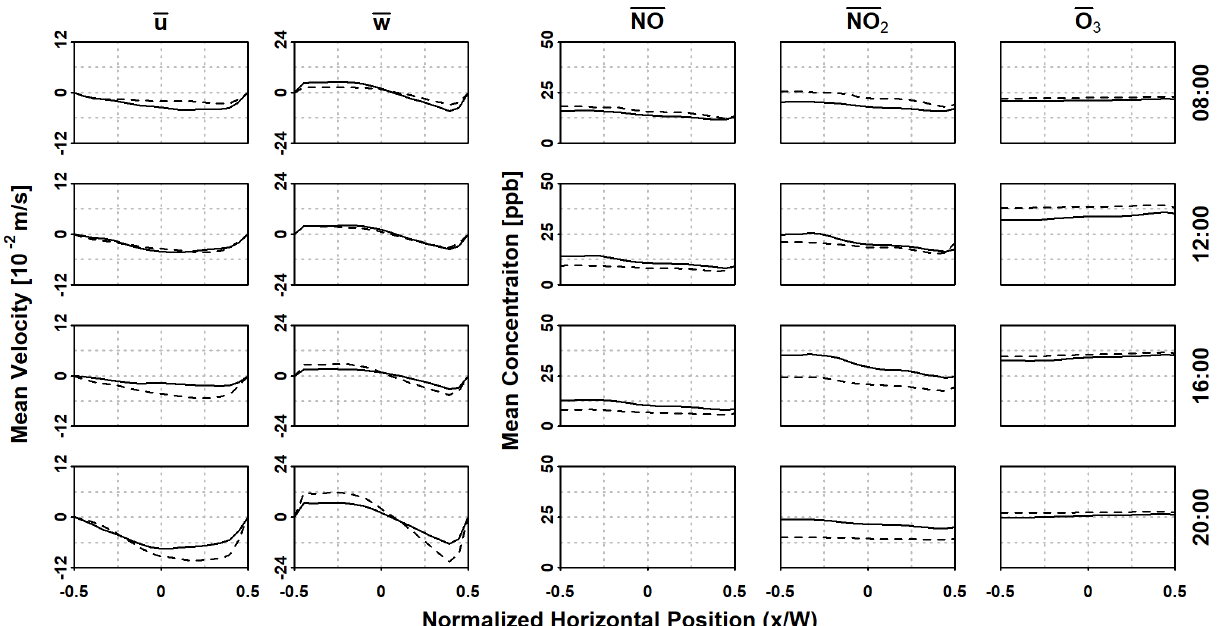
Figure 11. Comparison of horizontal station profiles of mean velocity components and species concentrations at a normalized elevation of z/H = 0 . 75 for transient and stationary model runs at various points of time in UTC. Solid lines indicate transient runs, and dashed lines indicate stationary